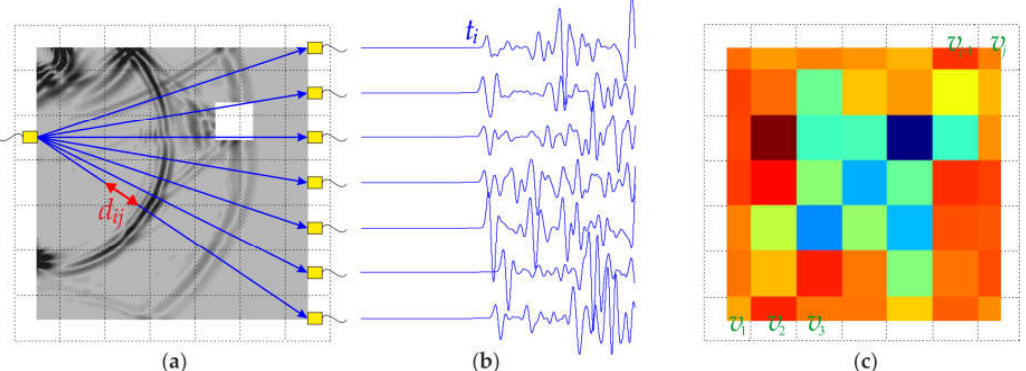
Figure 1. Schematic diagram of ultrasound tomography: ( a ) cross-section divided into pixels, with an indicated transmission point, receivers and a simulated wave field; ( b ) wave propagation signals; ( c ) tomographic image.